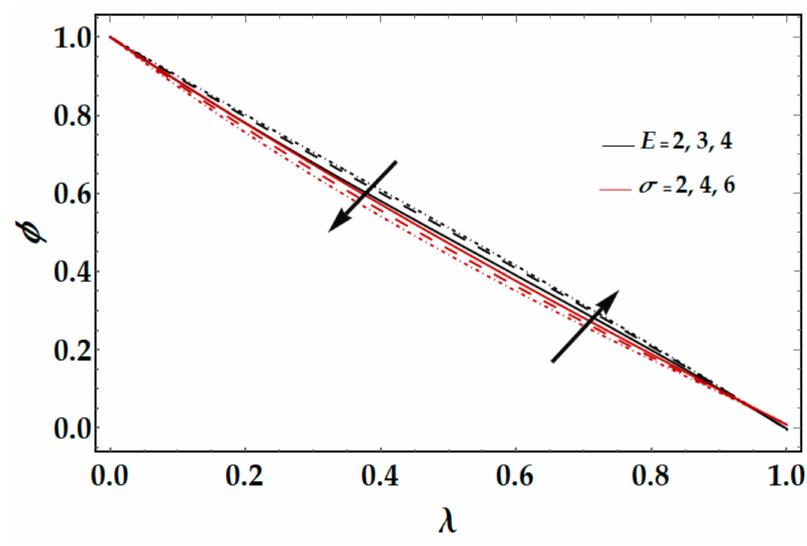
Figure 12. Implications of S Q , S M on concentration function φ ( λ ) .